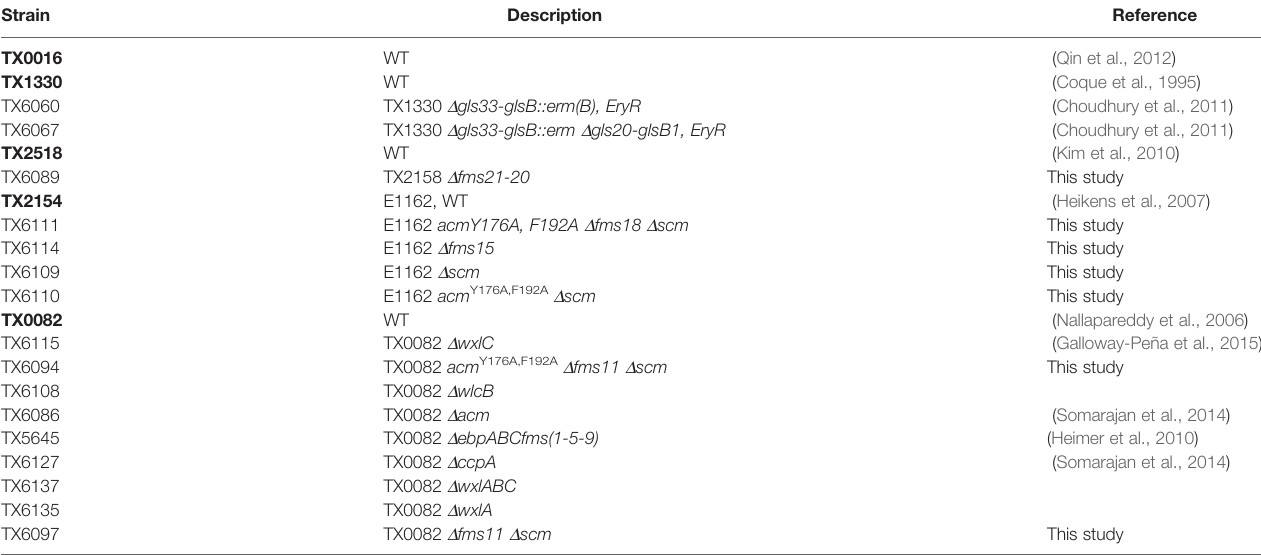
TABLE 1 | List of E. faecium mutants used for this study.